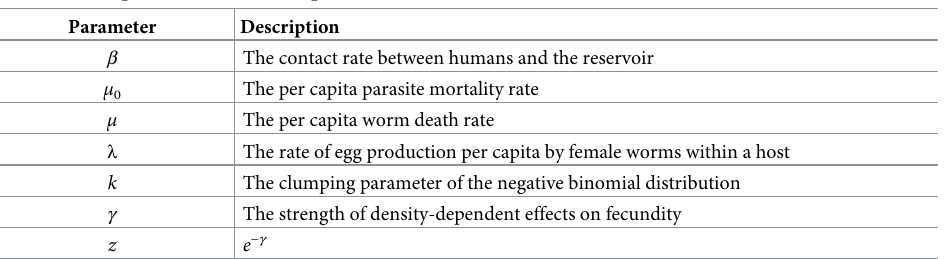
Table 1. Description of the associated parameters in model